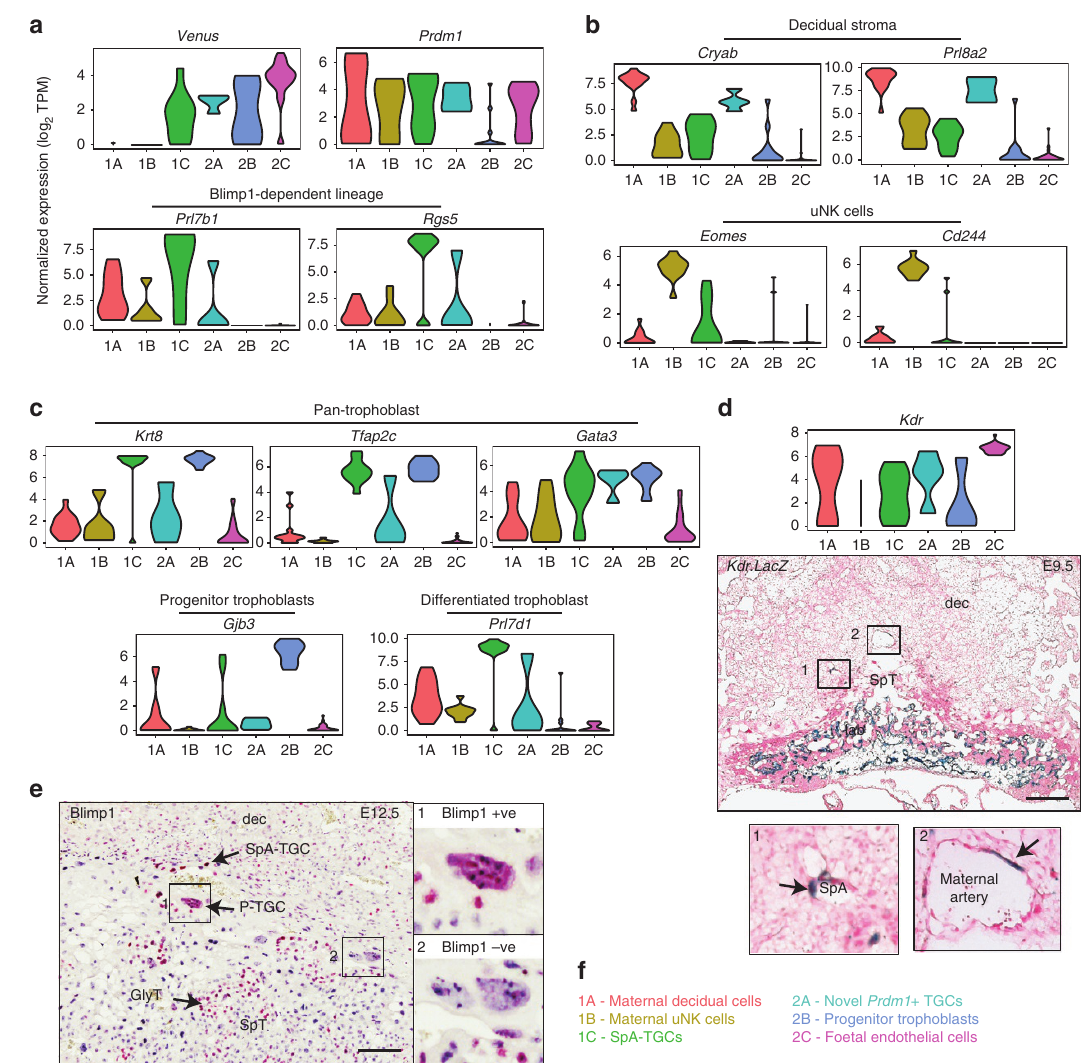
Figure 3 | Marker genes defining discrete cell types. ( a ) Violin plots detailing expression levels of Prdm1 , paternally inherited Prdm1-Venus reporter and Prdm1- dependent lineage markers Prl7b1 and Rgs5 . Scale is log 2 tags per million (TPM). ( b ) Expression of decidual stroma markers Cryab and Prl8a2 in group 1A; expression of uNK cell markers Eomes and Cd244 revealing enriched expression in group 1B. ( c ) Violin plots of generic trophoblast markers Krt8 , Tfap2c and Gata3 , progenitor trophoblast marker Gjb3 and Prl7d1 marking differentiated trophoblasts. ( d ) Violin plot of Kdr expression, and X-gal staining of a paternally inherited Kdr.LacZ knock-in allele demonstrate expression in endothelial cells within the labyrinth and SpA-TGCs. Bar, 200 m m. ( e ) Anti-Blimp1 immunostaining of E12.5 placenta reveals Blimp1 þ P-TGCs. Bar, 100 m m. ( f ) The cell types represented by the six groups. Abbreviations: dec, decidua; SpT, spongiotrophoblast; lab, labyrinth; SpA, spiral artery; TGC, trophoblast giant cell; SpA-TGC, spiral artery TGC; P-TGC, parietal TGC; GlyT, glycogen